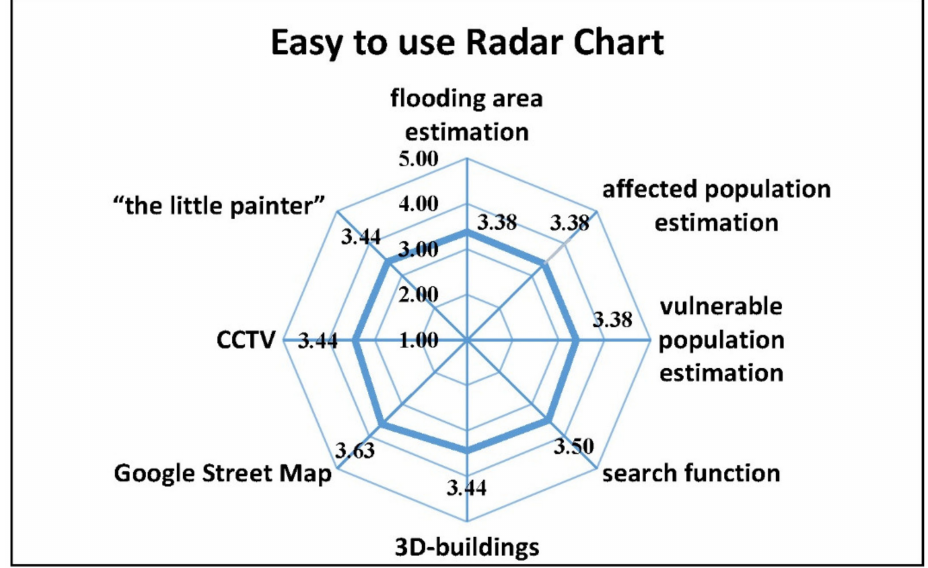
Figure 23. Assessment of the ease of use of the platform’s functions, based on the results of the questionnaire survey.